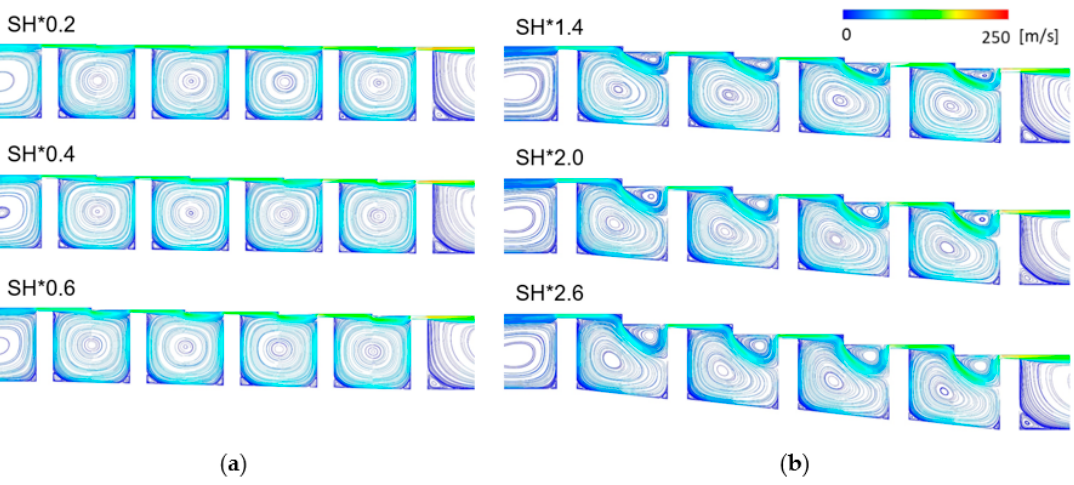
Figure 9. Change in the cavity flow structure according to SH. ( a ) High ‐ discharge ‐ coefficient group. ( b ) Low ‐ discharge ‐ coefficient group.